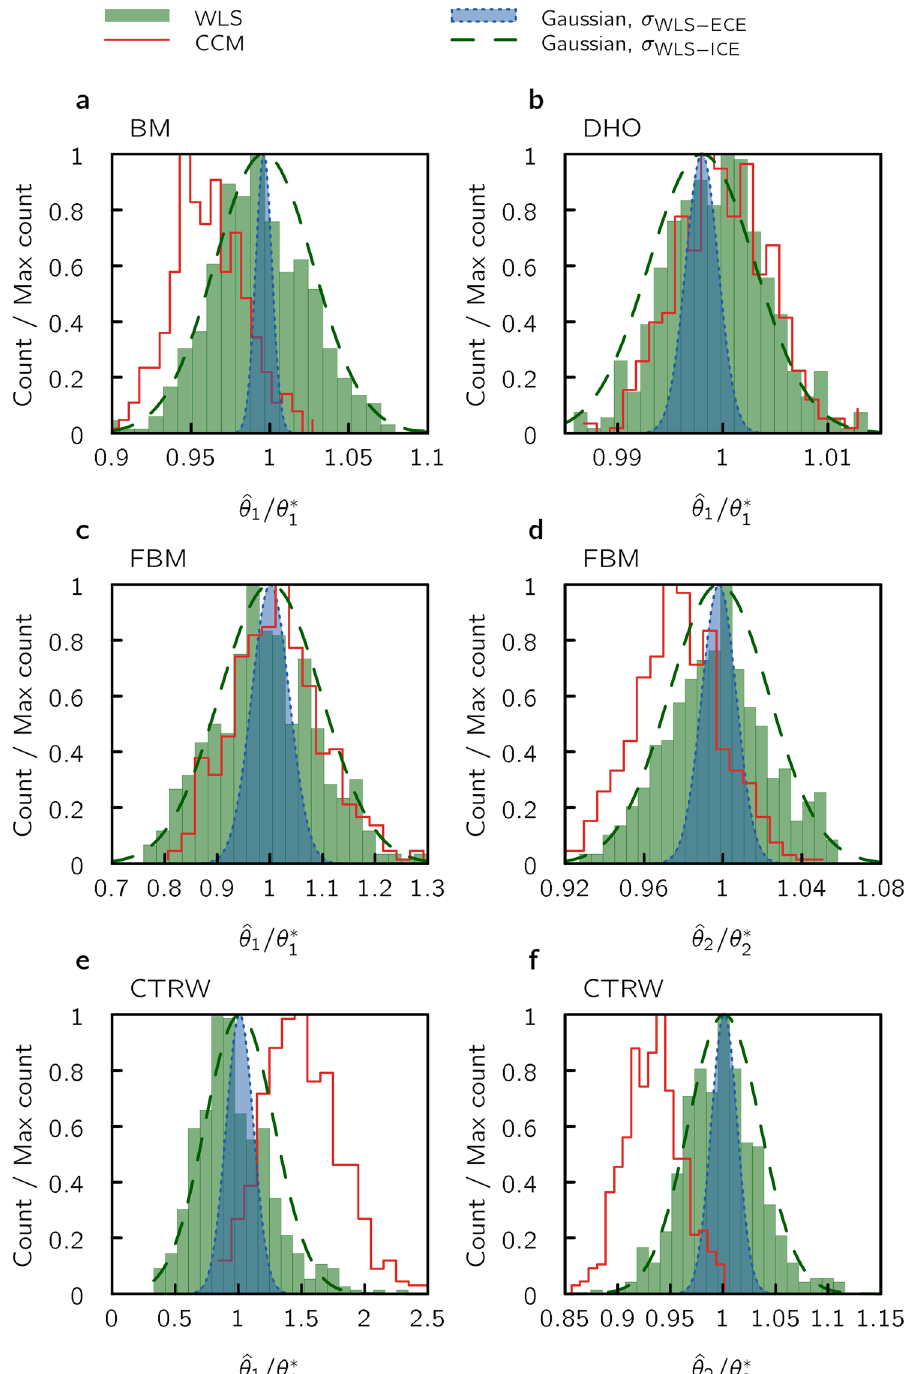
Figure 1. Histograms of fitted parameters for two WLS methods and CCM compared to theoretical predictions. Each method is tested on: ( a ) Brownian motion (BM), ( b ) damped harmonic oscillation (DHO) ( c , d ) fractional Brownian motion (FBM), and ( e , f ) continuous time random walk (CTRW). In each test, we generate S = 500 data sets, each consisting of M = 1000 trajectories sampled at N = 75 time points (histograms). Panel (a) shows the MSD prefactor (proportional to the diffusion constant) for BM, panel (b) shows DHO fitting parameter θ 1 , while panels (c–f) left and right panels show the MSD prefactor θ 1 , and the exponent θ 2 , respectively. For comparing WLS-ICE and WLS-ECE to the histograms based on the S data sets, we place Gaussian functions with their center positions at the mean of the WLS-fitted parameters. The widths of the Gaussians correspond to the parameter uncertainty estimated by the fit method (averaged over the S number of fits). The CCM fits for BM and CTRW exhibits a strong bias in the parameter value (not centered on the analytical prediction), and the WLS-ECE fit gives an error estimation, see Section B in Supplementary Information, that is much too small. The new WLS-ICE procedure (Methods) works well, i.e., exhibits